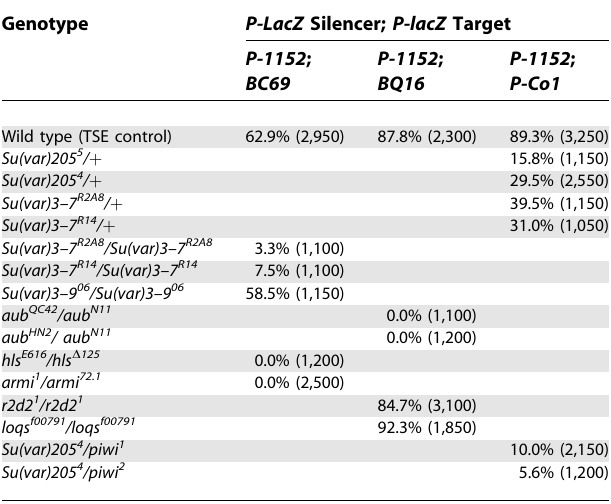
Table 1. TSE Levels in Mutant Contexts